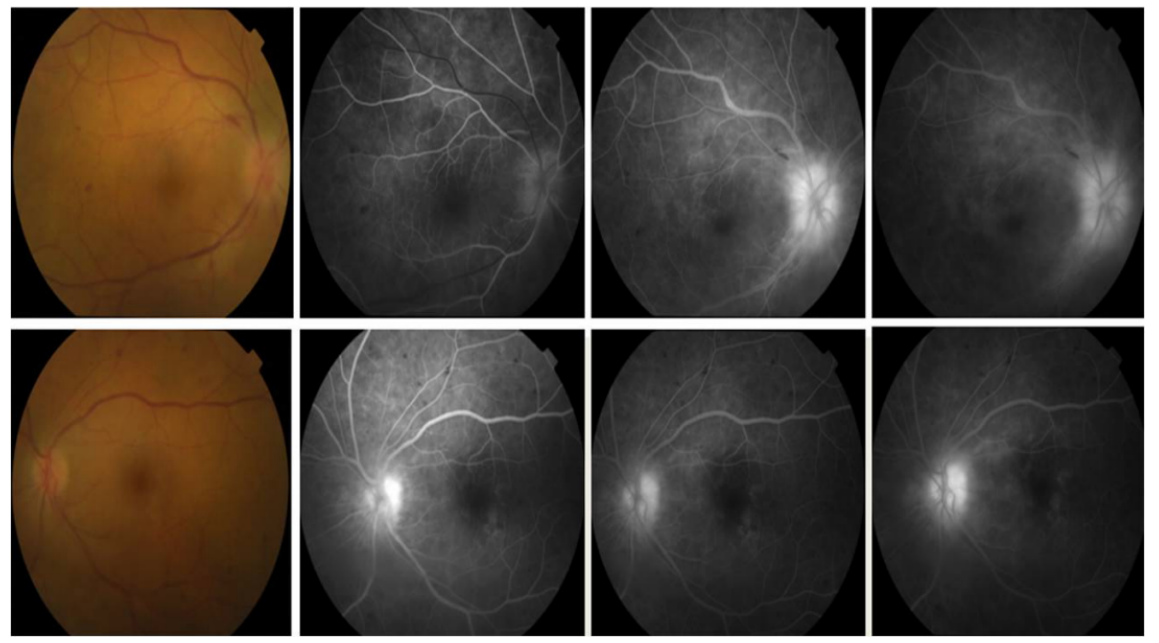
Figure 1: Initial retinography and angiography (RE and